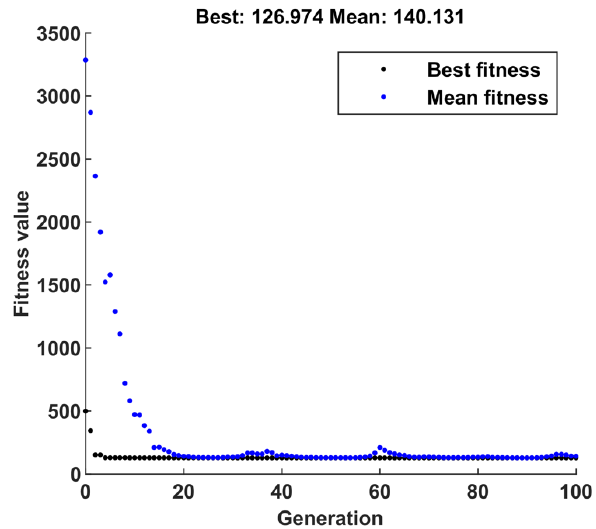
Figure 12. GA evolution of parameter estimation.